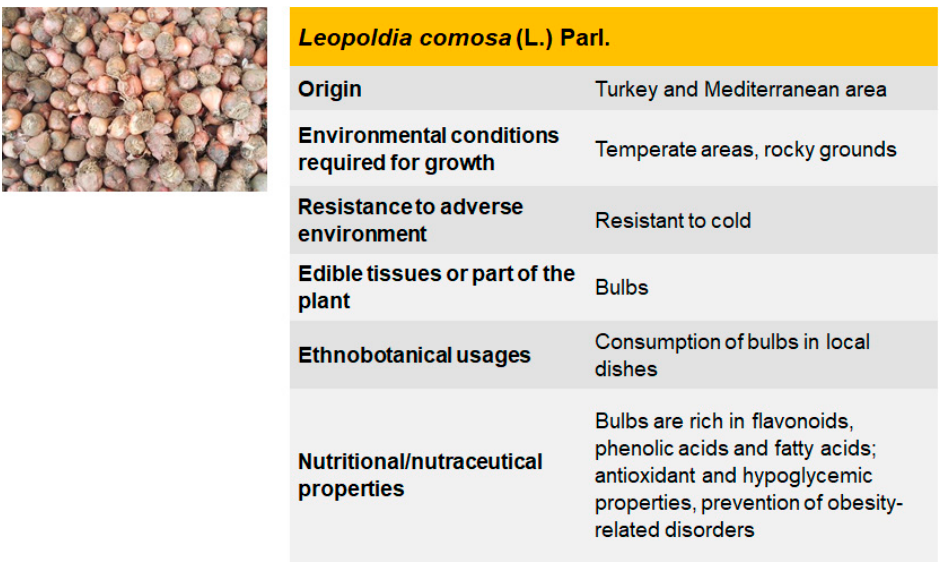
Figure 5. Scheme of the main features of L. comosa . (Source photo: biodiversitàpuglia.it [35]). Table 5. Some examples of polyphenol and fatty acid content in L. comosa . The bulbs of L. comosa are characterized by a typical strong sour and bitter taste Leopoldia comosa Total Polyphenols Total Flavonoids Total Fatty Acids Palmitic acid 16.2 mg/g of fatty acids fraction [69] Palmitic acid 15.5% of fatty acid composition [70] [72] Palmitic acid 17.5 mg/g of fatty acids fraction 5.74 mg/g FW [69] [69]